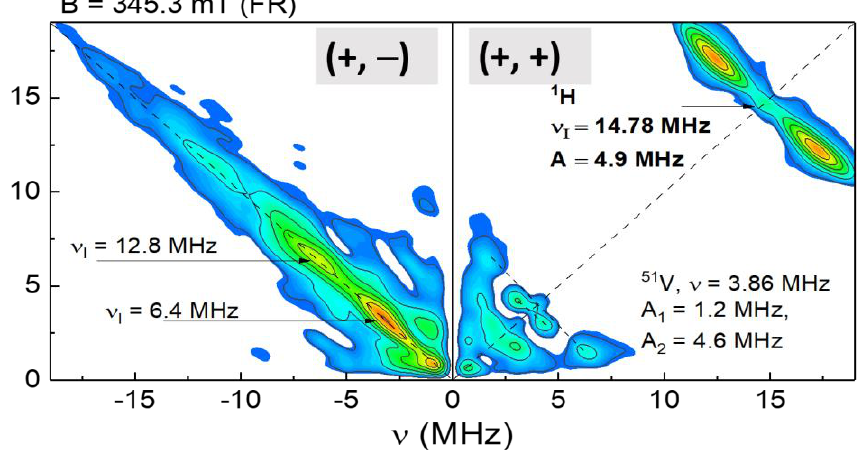
Figure 7. FR HYSCORE for A2.